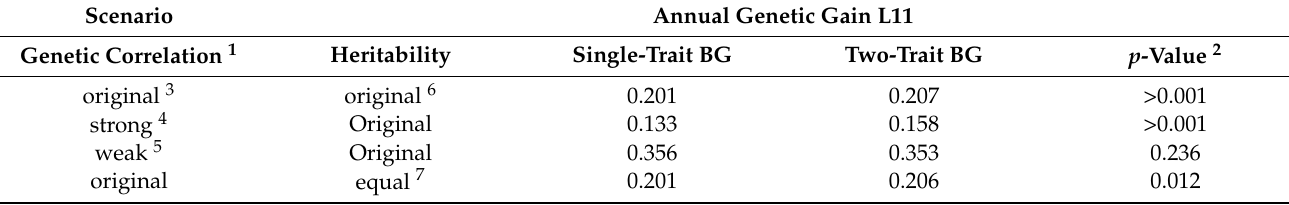
Table 3. Sensitivity analysis on the effect of differences in heritability or the strength of genetic correlation for the total number born (TNB) and dead piglets on day 11 (D11) on an annual genetic gain for live piglets at day 11 (L11). For each scenario, a single-trait breeding goal and a two-trait breeding goal were